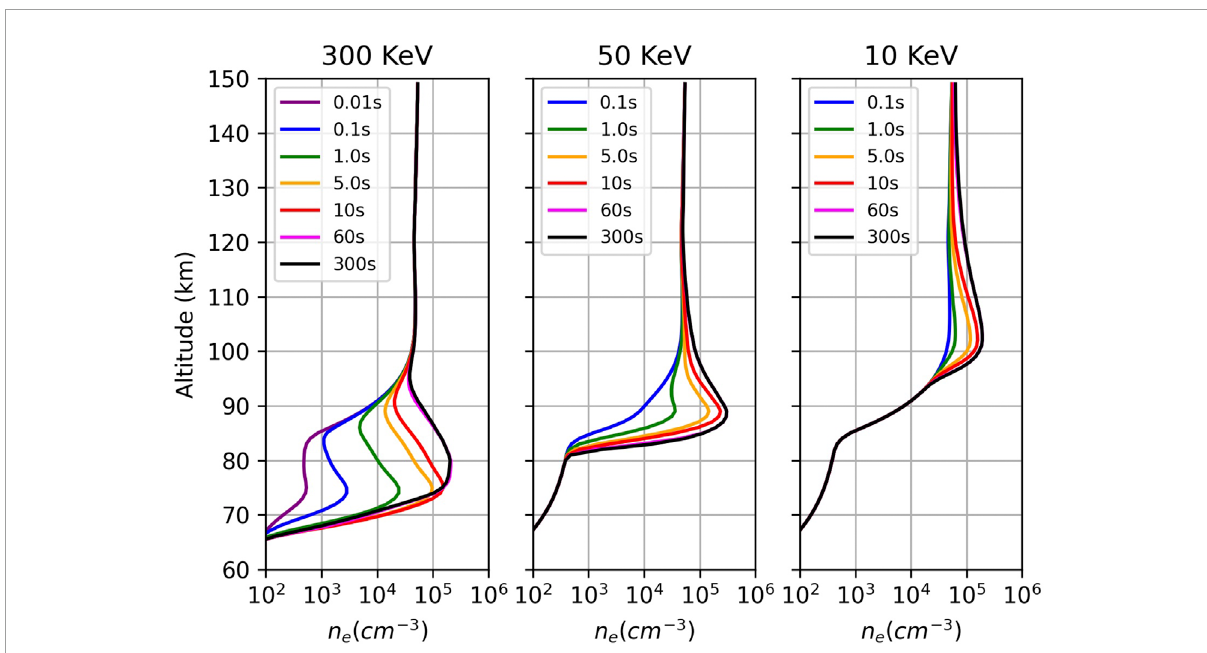
FIGURE 4 The electron density vs. altitude is plotted to show the relaxation time for a monoenergetic flux at 300 keV, 50 keV, and 10 keV shown as the left, middle, and right columns, respectively. All examples have an energy flux of 1 mW / m 2 . We find that the 50 keV and 10 keV beams come into near steady state after 10 s, while the 300 keV beam takes 60